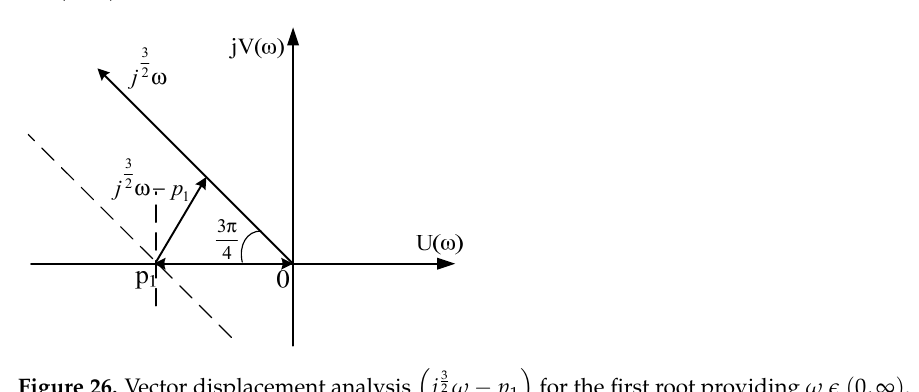
Figure 26. Vector displacement analysis (cid:4672)𝑗